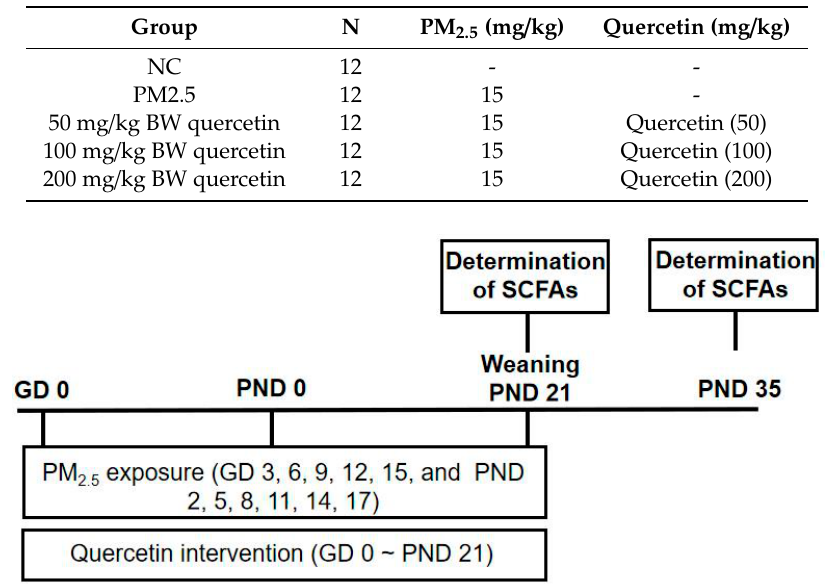
Figure 1. The experimental scheme of mouse maternal exposure to PM 2.5 and received intragastric administration of quercetin. Maternal mice and offspring underwent further analysis after weaning.